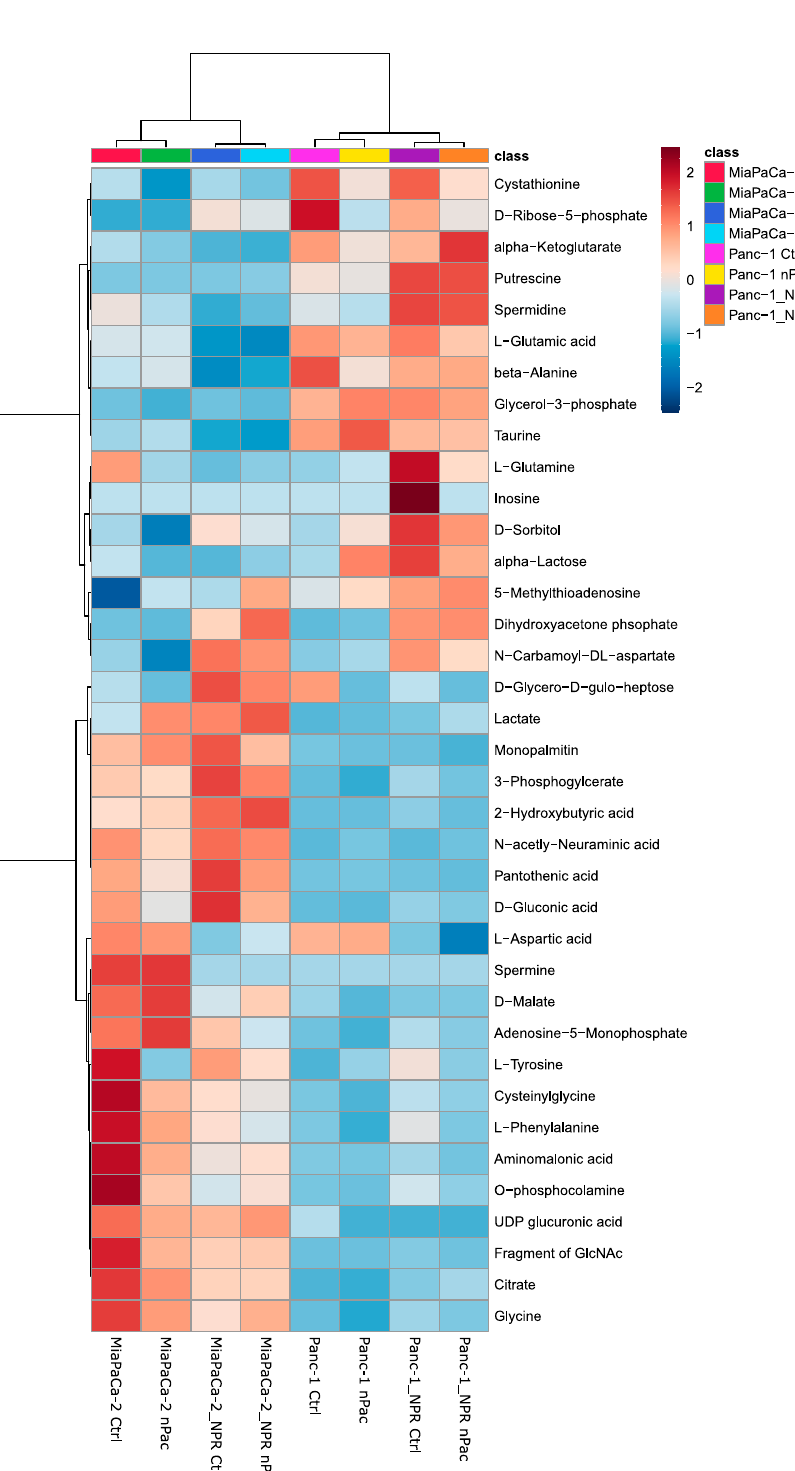
Figure 4. Heat map of significantly altered metabolites in chemotherapy-resistant and parental cell lines after chemotherapy treatment. The heat map describes all significantly altered metabolites identified by untargeted GC / MS profiling in chemotherapy-resistant and parental PDAC cell lines upon application of nab-paclitaxel. Cell lines were treated for 72 h. nPac: nab-Paclitaxel treated; Ctrl: vehicle treated. Range-scaled z-scores are shown. n =